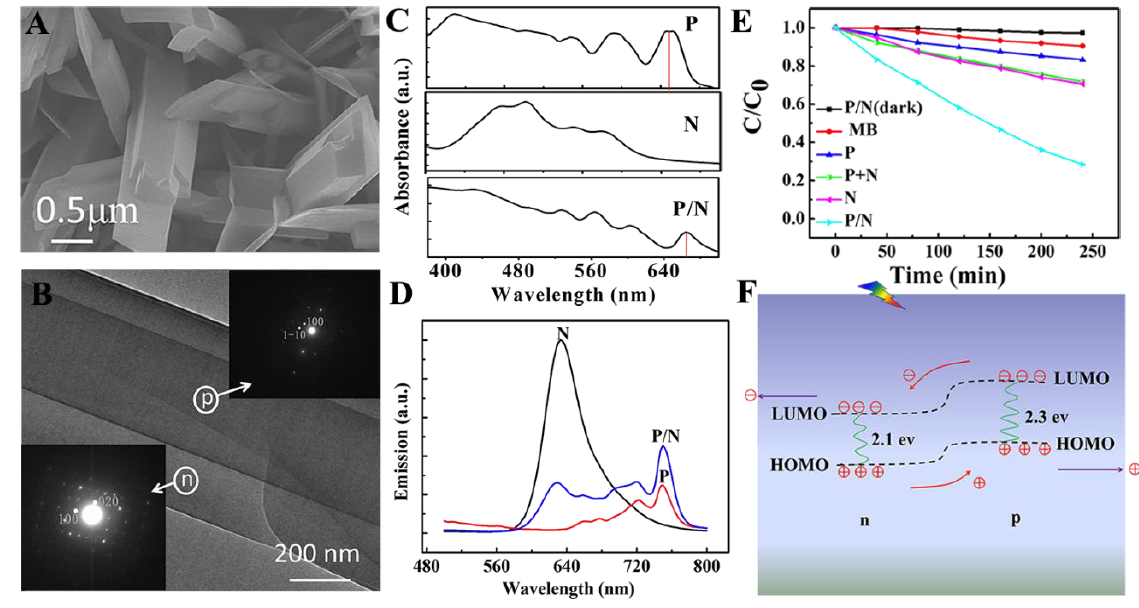
Figure 4. ( A ) The scanning electron microscope (SEM) image of tetraphenylporphyrin (H 2 TPP)/ N,N-(dicyclohexyl) perylene-3,4,9,10-tetracarboxylic diimide (CH-PTCDI) nano-heterojunctions; ( B ) TEM image of a single p/n nanostructure; the insets are the corresponding electron diffractions; ( C ) The UV-visible and ( D ) the fluorescence spectra of the obtained samples; ( E ) Photocatalytic degradation of MB with different samples under visible-light irradiation ( λ > 400 nm); ( F ) operating principle of H 2 TPP/CH-PTCDI nanostructures. Reproduced with permission from [65]. Copyright 2013, Royal Society of Chemistry. MB, methyl